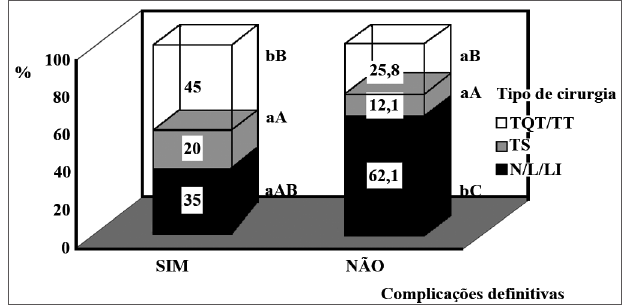
Figura 2. Distribuição percentual de pacientes tireoidectomizados, quanto a complicações cirúrgicas definitivas, em relação ao tipo de cirurgia realizado (N / LI / L: nodulectomia / loboistimectomia / lobec- tomia; TS: tireoidectomia subtotal; TQT / TT: tireoidectomia quase-total / total). A comparação dentro de cada grupo, com ou sem complica- ções, é representada pelas letras maiúsculas e a entre os grupos, pelas minúsculas [teste de Goodman; b > a, C > B > A ( p <